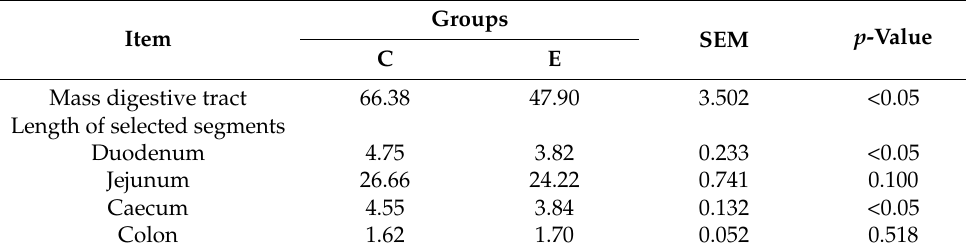
Table 5. Mass (g) digestive tract and length (cm) of selected segments, calculated for 1 kg of body